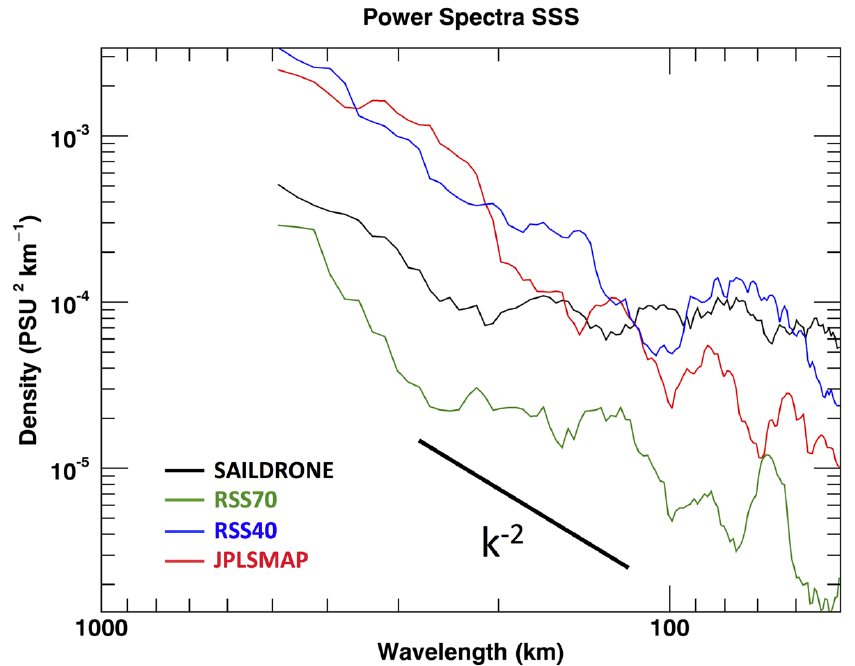
Figure 8. Power spectra for the three satellite-derived SSS products and Saildrone SSS. For the purpose of reference, the k − 2 slope is overlaid.